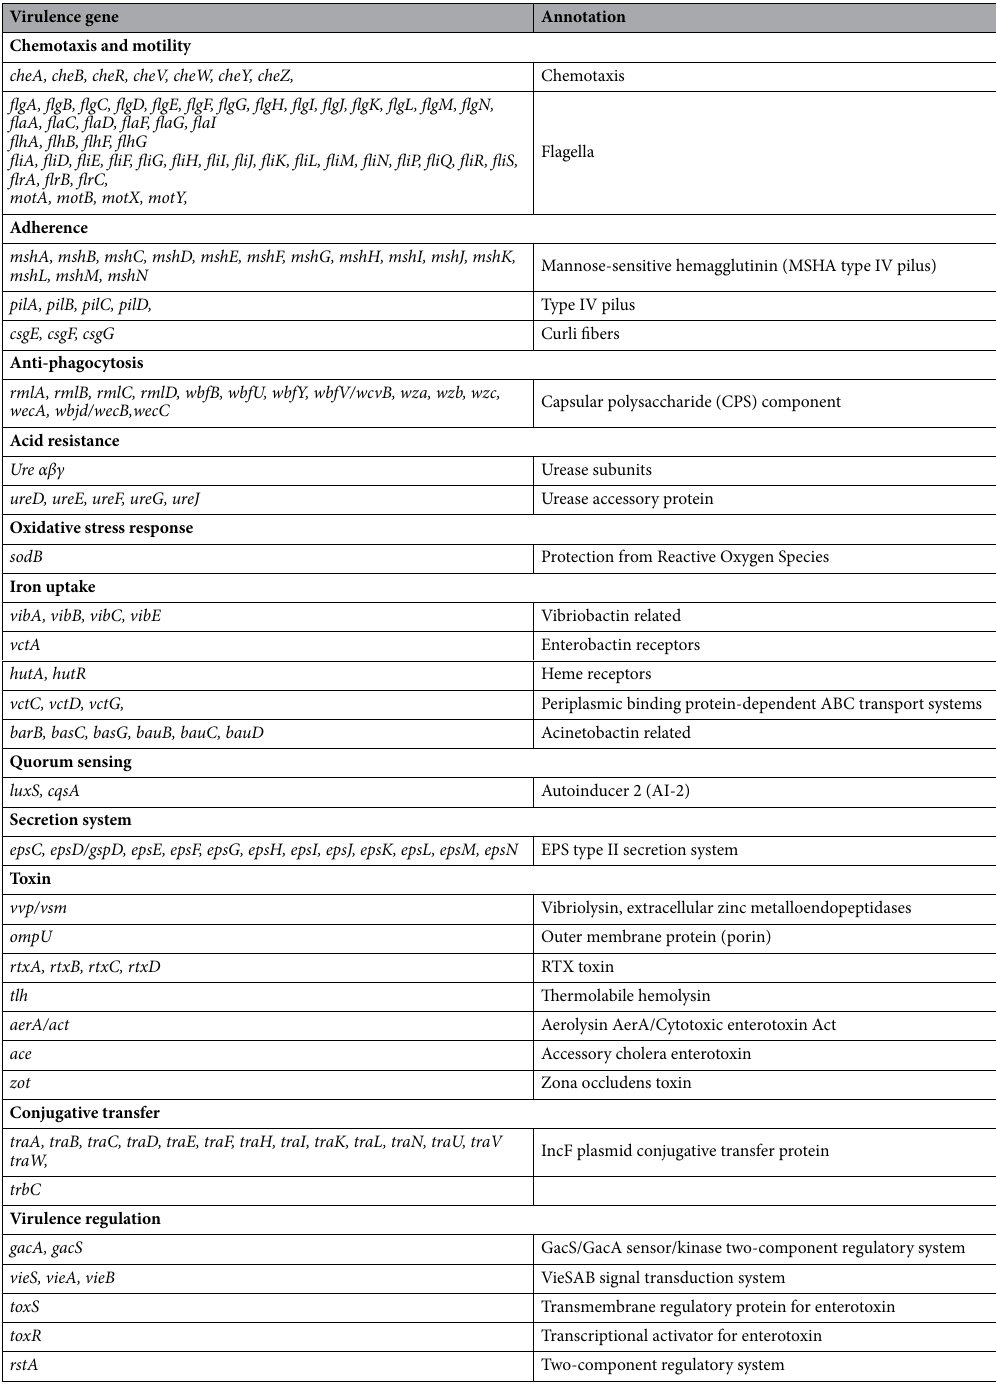
Table 2. Overview of putative virulence genes identified in the V. echinoideorum